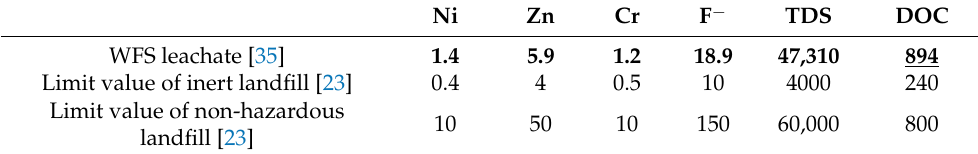
Table 5. Leachate contaminants concentration using EN 12457-4 and EULFD limits (value in mg/kg). Ni Zn Cr F − TDS Limit value of inert landfill